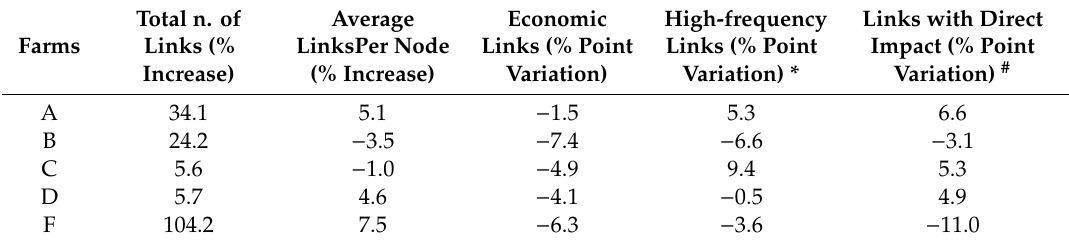
Links with Direct